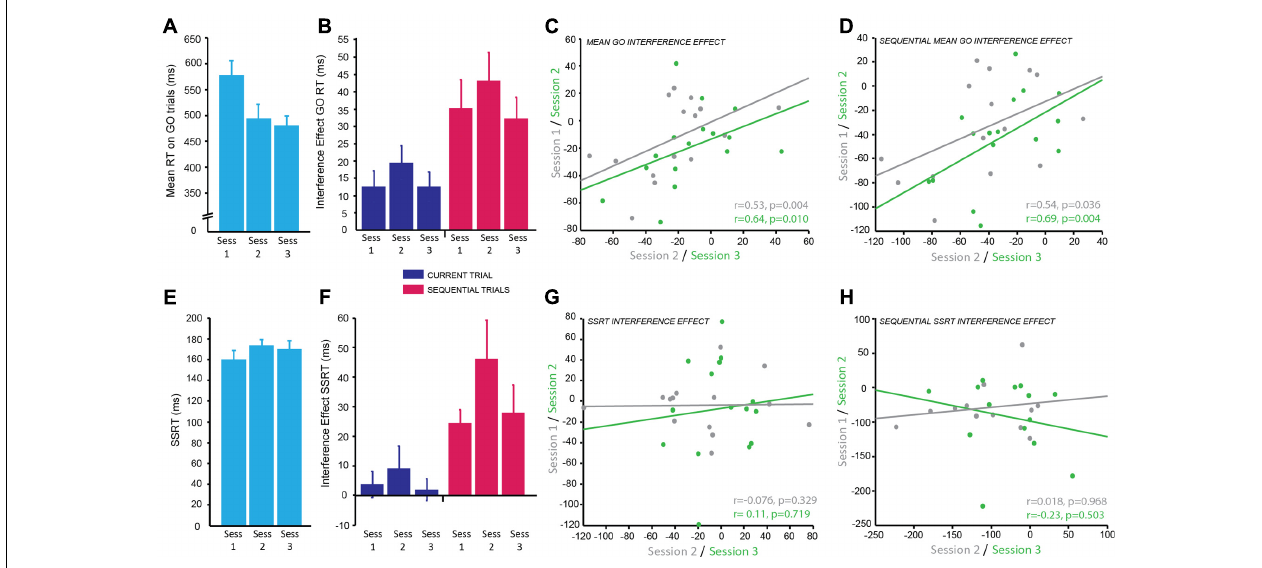
FIGURE 4 | Combined Simon-Stop-Signal Task: the Simon interference effect showed moderate reliability across testing sessions but the stop-signal reaction time (SSRT) interference effect did not. (A) Mean reaction time (ms) on GO trials; significantly decreased from session 1 to 2 with practice effects and then plateaued between sessions 2 and 3. (B) The interference effect for GO trials (difference in RT between congruent and incongruent conditions) across sessions for current trials (blue) and sequential trials (pink). The interference effect was significantly greater for sequential trials (pink) compared to current trials (blue). The interference effect was stable across sessions. (C,D) Significant positive correlation between the mean interference effect for each subject between sessions 1 and 2 (gray) and sessions 2 and 3 (green) for current trials (C) and sequential trials (D) demonstrating moderate test–retest reliability. (E) Mean SSRT across sessions; no significant change in SSRT with session. (F) The combined Simon-Stop-Signal measure – the SSRT interference effect – for current trials (blue) and sequential trials (pink). The SSRT interference effect for current trials (blue) was not significantly different from zero, however, the SSRT interference effect for sequential trials (pink) was significant. This remained stable across sessions. (G,H) No relationship between the SSRT interference effect in session 1 vs. 2 (gray) and session 2 vs. 3 (green) for current trials (G) and sequential trials (H) . The SSRT interference effect showed poor test–retest